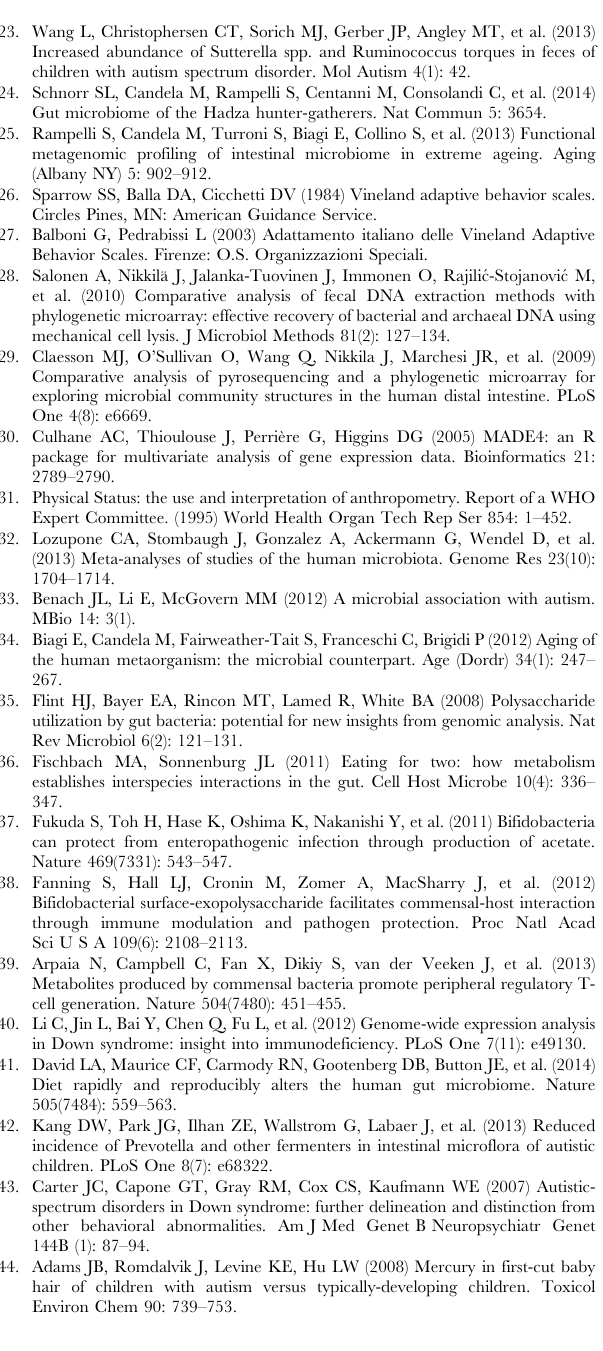
Table S3 Level of cognitive impairment, Aberrant Behavior Checklist (ABC) and Vineland Adaptive Behavior Scale (VABS) scores in the enrolled Down Syndrome